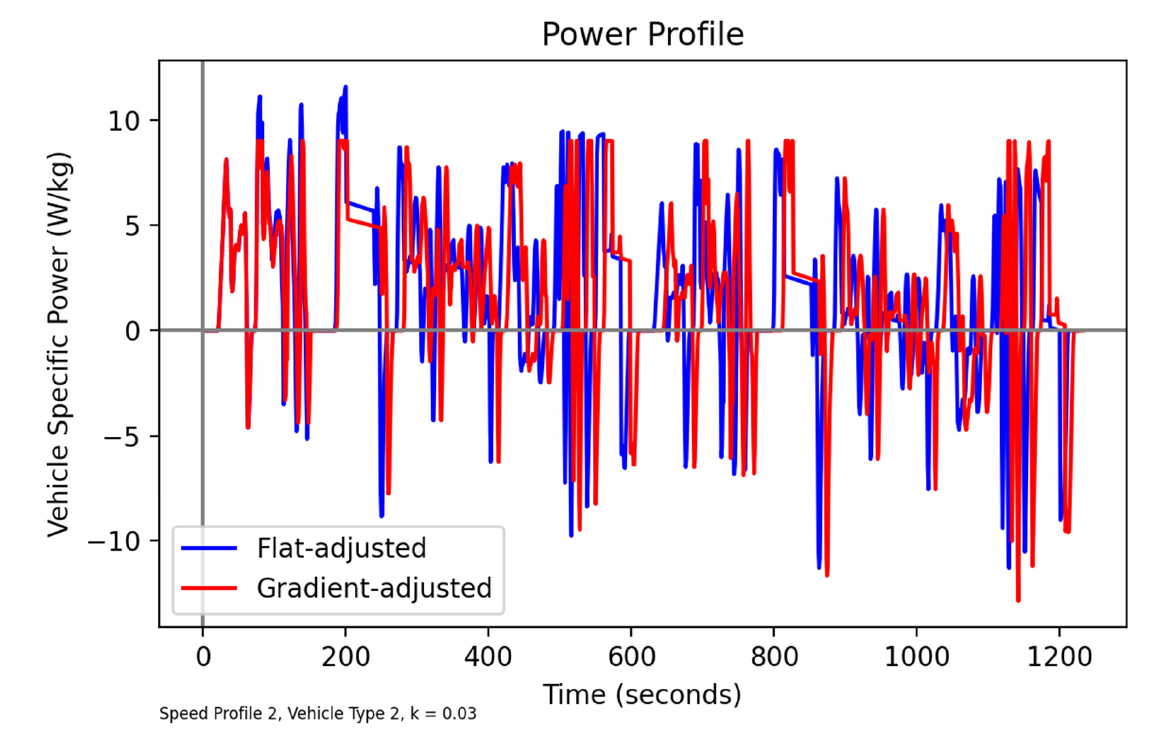
Figure 11. Comparison of VSP profiles following Flat ( k = 0) vs. Gradient ( k = 0.03) adjusted speed profiles, both evaluated on k = 0.03 terrain (Both adjusted from WMTC Reference Cycle 2; Vehicle Type 2).